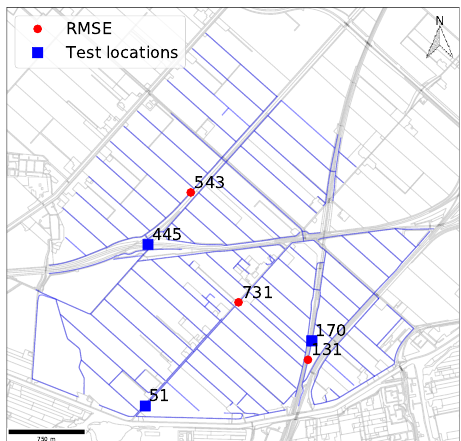
Figure 8. Optimum sensor locations obtained by minimization of root mean square error (RMSE) (indicated by red circles) and three test locations (blue squares) for showing the performance of the placement.